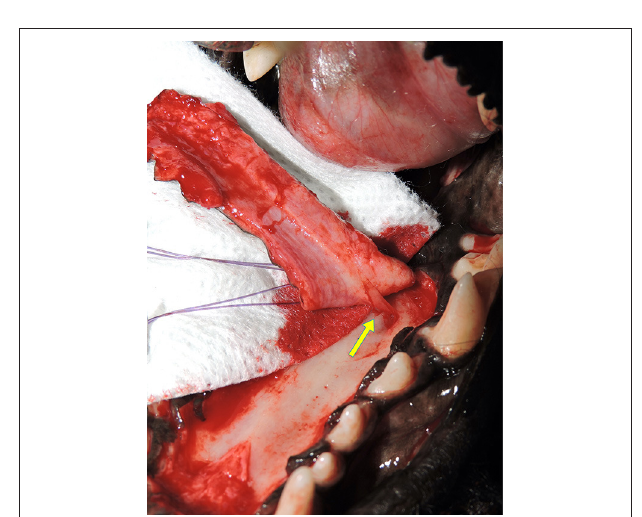
FIGURE 6 | Preservation of blood supply. Photograph showing the major palatine artery as it exits the major palatine foramen at the level of the maxillary fourth premolar tooth halfway between midline and the alveolar process